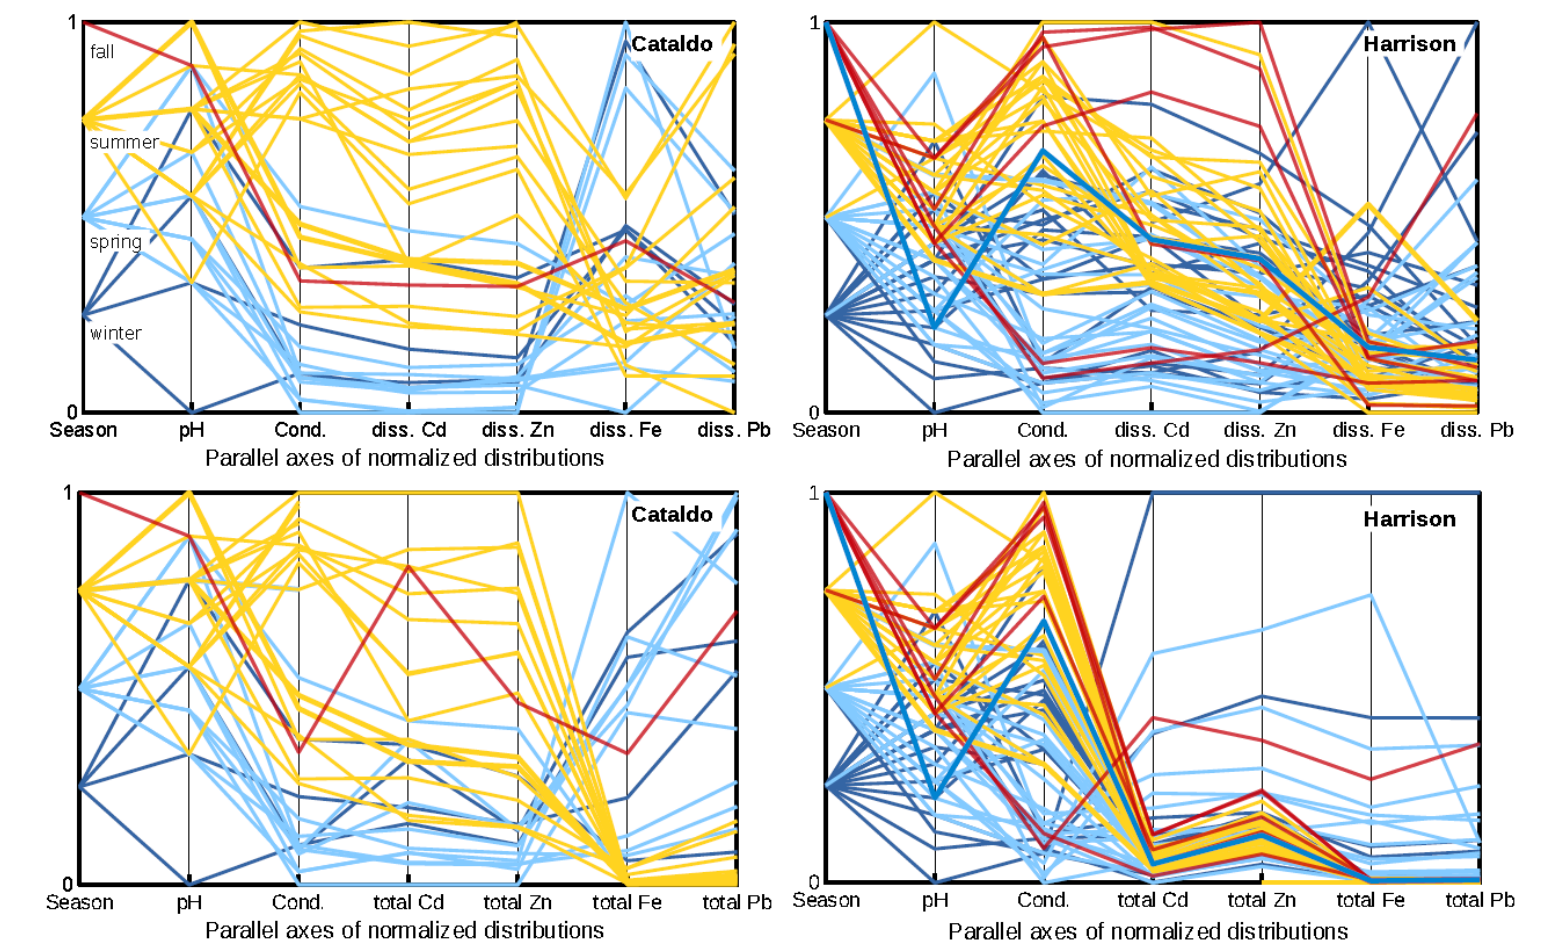
Figure 8. Parallel coordinates presentation of normalized distributions (1 = maximum, 0 = minimum) of the pH and conductivity and dissolved (diss.) and total concentration of metals by season at the Cataldo (upper basin) and Harrison (lower basin) sites on the Coeur d’Alene River. Seasonal designation by color: winter = dark blue, spring = light blue, summer = yellow, fall = red.